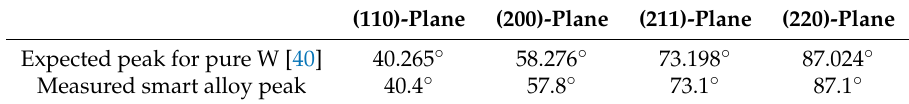
Figure 2. XRD measurement of an W-12Cr-0.5Y alloy as deposited, exemplary for the alloys used in this work. The black, dashed lines indicate the expected peak-positions for W based on the database [40]. Table 1. Positions of peaks in the XRD shown in Figure 2 in comparison to the peaks of pure